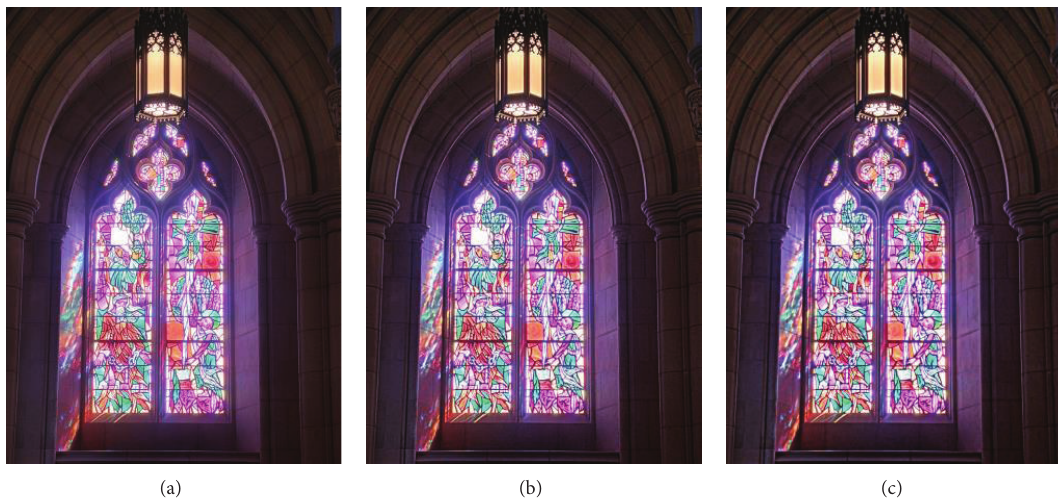
Figure 8: Visual inspection: the effect of free parameter 𝑟 on detail enhancement. We have found that 𝑟 = 2 is sufficient for fine details extraction and gives better results for most cases. Higher value of 𝑟 brings in artifacts near strong edges. (a) 𝑟 = 1 ; (b) 𝑟 = 3 ; and (c) 𝑟 = 6